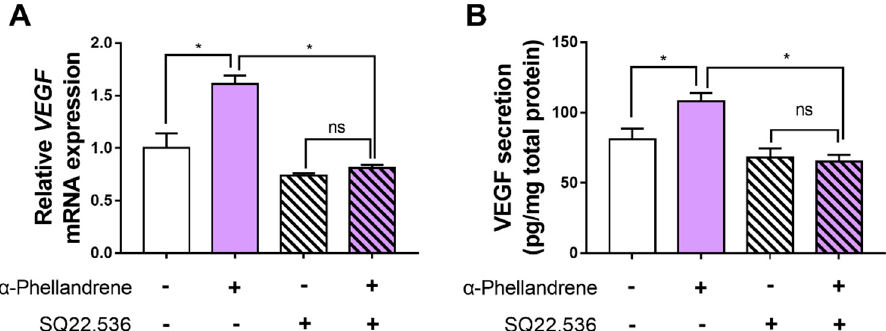
Figure 6. The inhibition of the cyclic adenosine monophosphate (cAMP) pathway blocks the effect of α -phellandrene on vascular endothelial growth factor (VEGF) production. ( A , B ) Dermal papilla cells (DPCs) were either treated with vehicle (dimethyl sulfoxide; DMSO) or 12.5 µ M of α -phellandrene for 6 h (for mRNA analysis) or 24 h (for protein analysis) and pretreated with vehicle or 50 µ M of SQ22,536 (cAMP inhibitor) for 1 h before α -phellandrene treatment. Then the mRNA was extracted and qPCR analyses were performed for VEGF expression changes. Each sample’s mRNA level was normalized to glyceraldehyde 3-phosphate dehydrogenase (GAPDH) and expressed relative to the value of the control (vehicle). The VEGF protein levels were normalized to the total amount of cellular protein. Results are shown as mean ± standard error of the mean (SEM) of three independent experiments. Statistically significant differences are marked as ns, not significant ( p > 0.05); * p < 0.05.